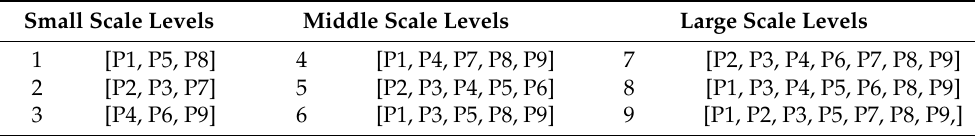
Table 6. Set of production tasks at different levels.